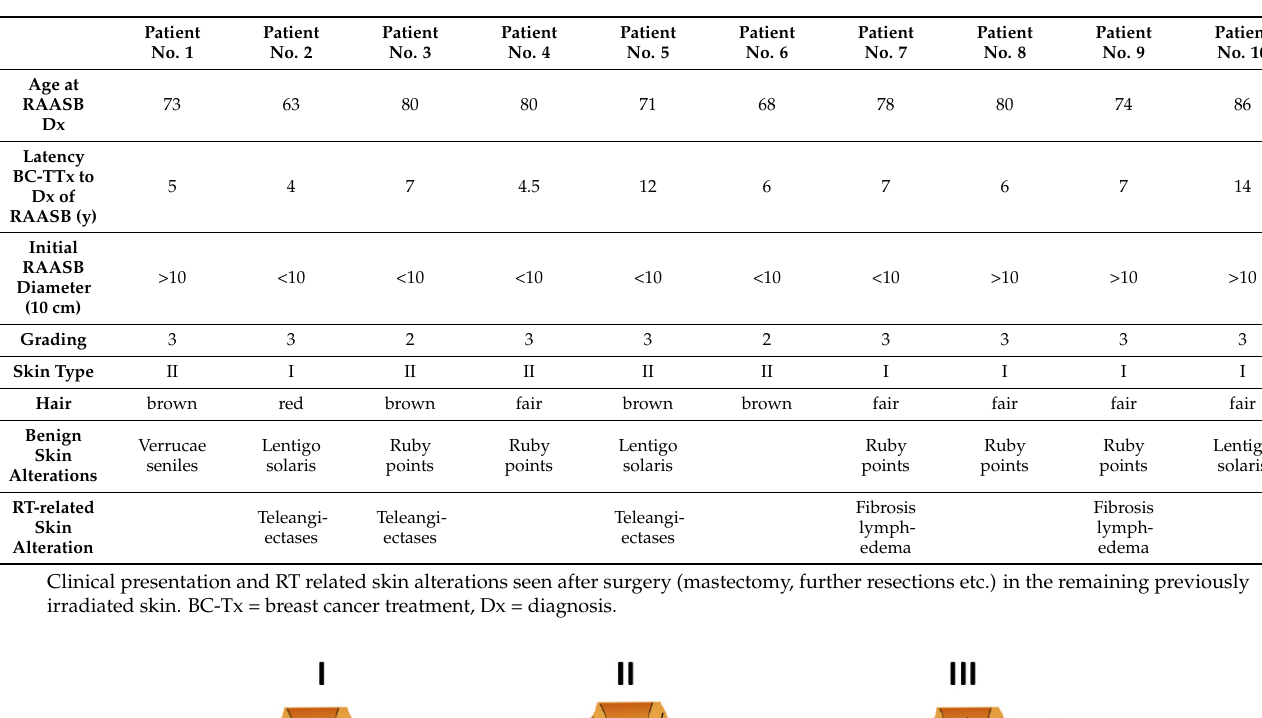
Table 2. Clinical presentation of patients with RAASB.